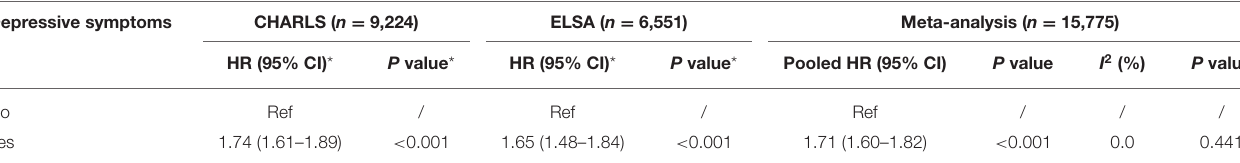
TABLE 3 | Association between baseline depressive symptoms and incident pain, using Cox regression model. Depressive symptoms